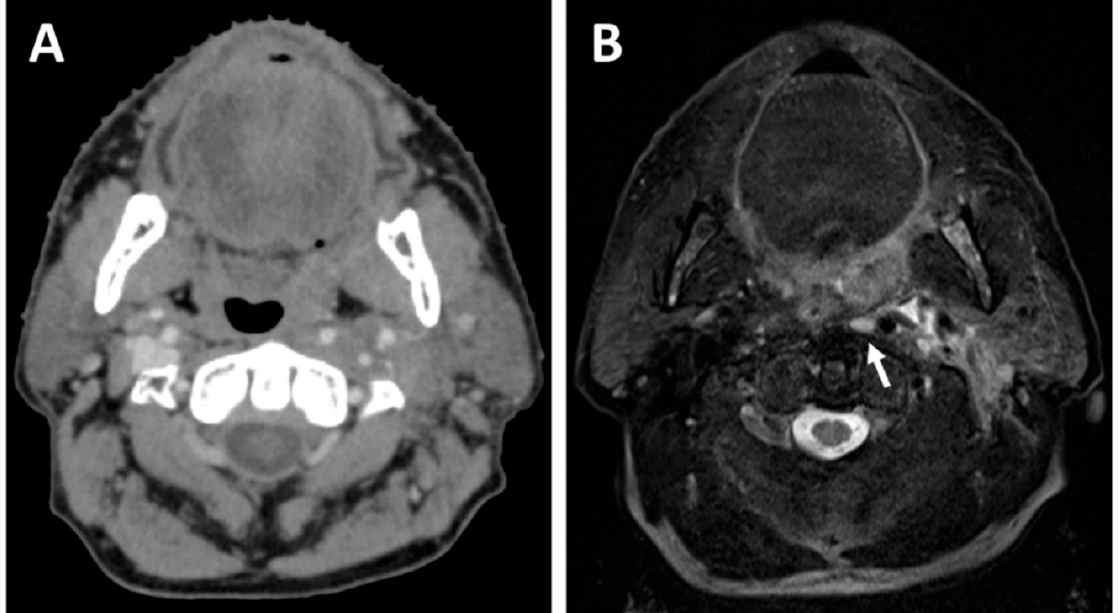
Figure 3. A 64-year-old patient with a cT2N1 p16-positive squamous cell carcinoma of the left tonsil planned for concurrent chemoradiotherapy. The planning CT ( A ) shows a mass effect originating from the left tonsil, whereas the planning T2-weighted MRI ( B ) allows better visualization of the left tonsil tumor and also detects a left retropharyngeal lymph node metastasis (white arrow).